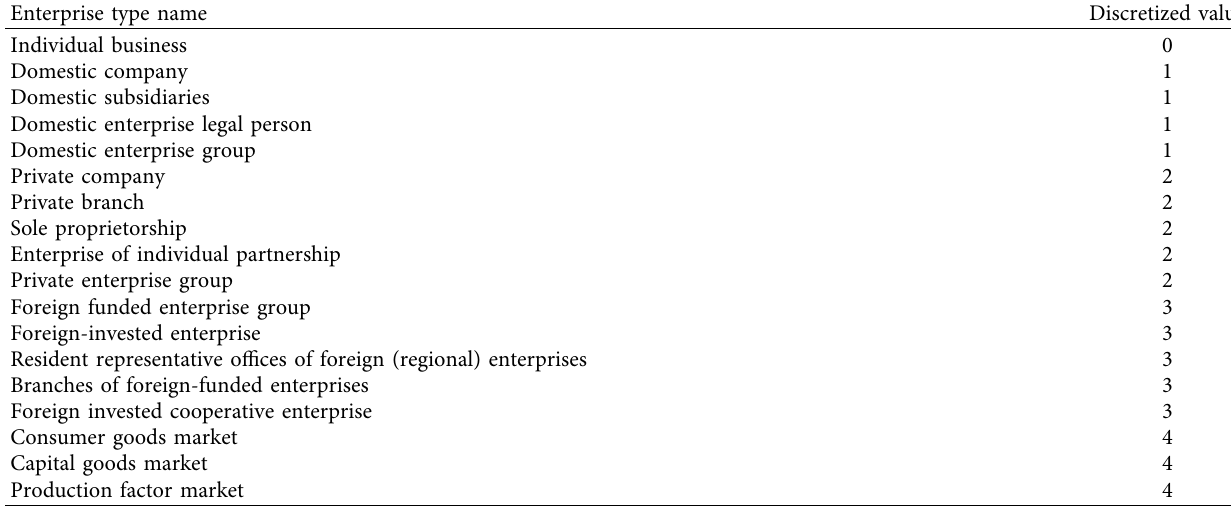
Table 3: Discretization of enterprise types.